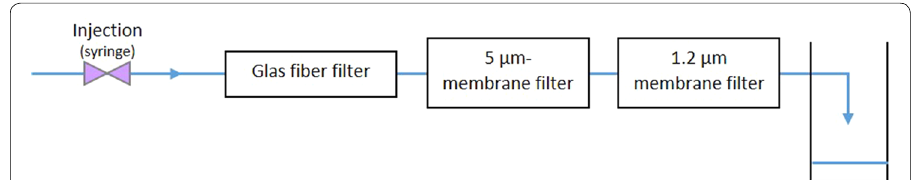
Fig. 2 Scheme of cascade filtration to estimate the grain size distribution of the solid phase in the